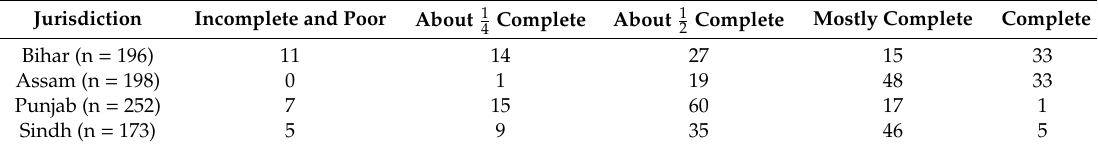
Table 3. Self-reported rate of knowledge of their local Water User Association or Village Level Committee (WUA / VLC)